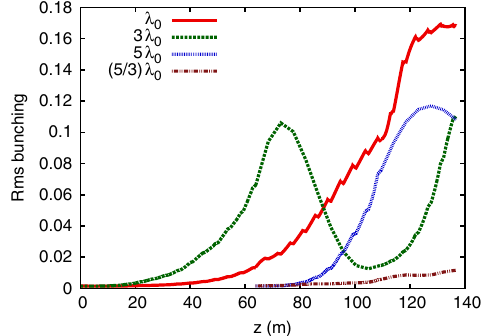
FIG. 9. Rms bunching parameter at various wavelengths as a function of distance for the three-stage example.